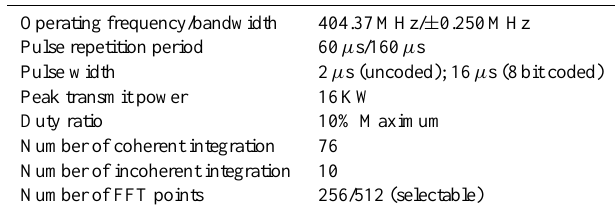
Table 1. Technical specifications of the Wind Profiler system at